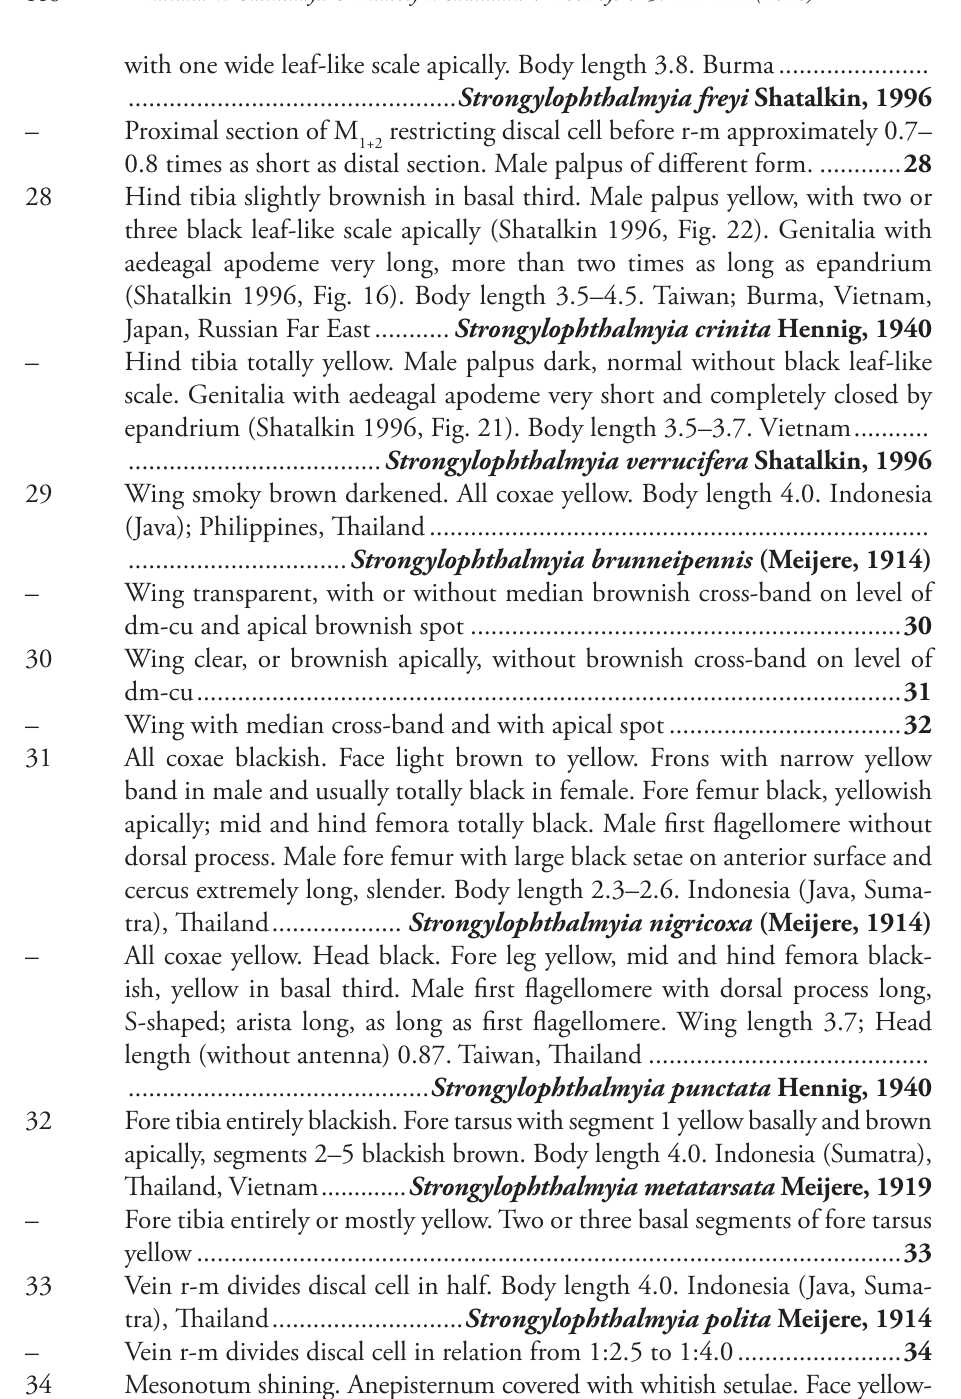
– Wing transparent, with or without median brownish cross-band on level of 30 Wing clear, or brownish apically, without brownish cross-band on level of – Wing with median cross-band and with apical spot .................................. 32 31 All coxae blackish. Face light brown to yellow. Frons with narrow yellow band in male and usually totally black in female. Fore femur black, yellowish apically; mid and hind femora totally black. Male first flagellomere without dorsal process. Male fore femur with large black setae on anterior surface and cercus extremely long, slender. Body length 2.3–2.6. Indonesia (Java, Suma- – All coxae yellow. Head black. Fore leg yellow, mid and hind femora black- ish, yellow in basal third. Male first flagellomere with dorsal process long, S-shaped; arista long, as long as first flagellomere. Wing length 3.7; Head length (without antenna) 0.87. Taiwan, Thailand ......................................... 32 Fore tibia entirely blackish. Fore tarsus with segment 1 yellow basally and brown apically, segments 2–5 blackish brown. Body length 4.0. Indonesia (Sumatra), – Fore tibia entirely or mostly yellow. Two or three basal segments of fore tarsus 33 Vein r-m divides discal cell in half. Body length 4.0. Indonesia (Java, Suma- – Vein r-m divides discal cell in relation from 1:2.5 to 1:4.0 ........................ 34 34 Mesonotum shining. Anepisternum covered with whitish setulae. Face yellow- ish. Palpus yellow. Mid tibia yellow in apical half. Body length 3.8–4.0.